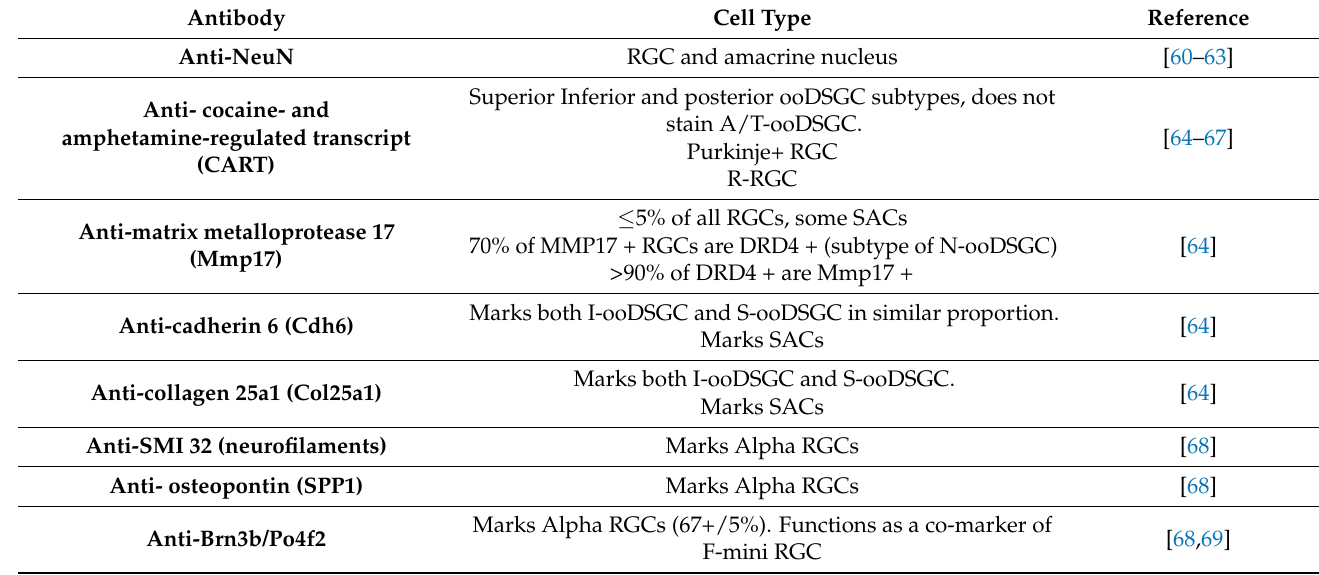
Table 2. Antibodies for RGC types and subtypes. The basic staining patterns and relevant characteris- tics are also provided where possible. Abbreviations: NeuN: reported synonym of the human protein ‘RNA binding fox-1 homolog 3 (cid:48) , encoded by the gene RBFOX3, CART: cocaine- and amphetamine- regulated transcript, Mmp17: matrix metalloprotease 17, Cdh6: cadherin 6, Col25a1: collagen 25a1, SMI 32: neurofilaments, SPP1 osteopontin, PV: Paralbumin, Brn3b: POU domain class 4 transcription factor 2, Brn3a: POU domain class 4 transcription factor 1, Brn3c: POU domain class 4